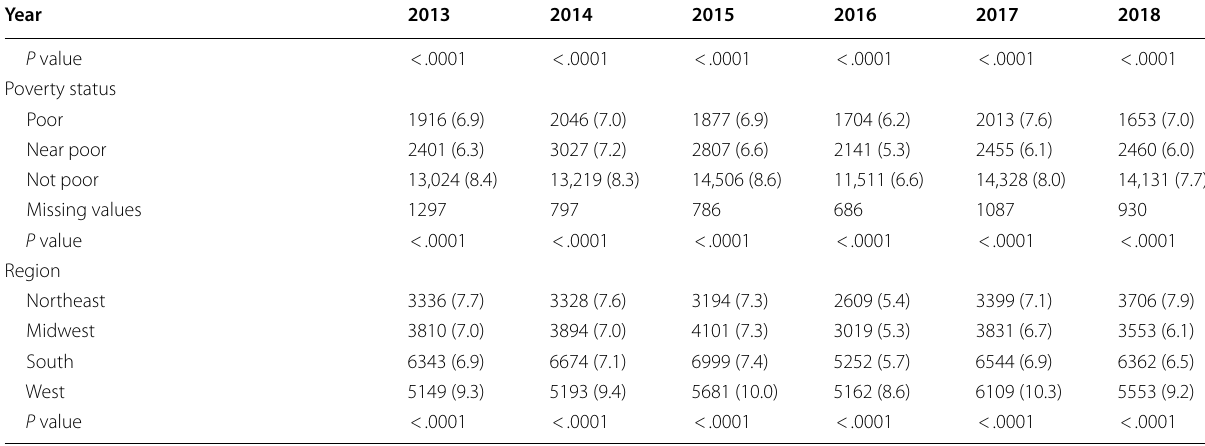
Table 2 Education level of adults over 25 years reporting hay fever diagnosis by frequency (in thousands)